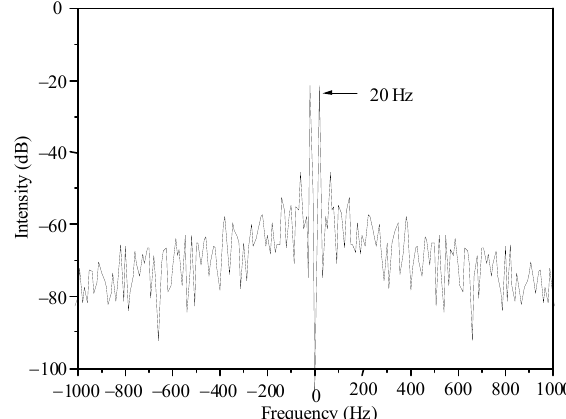
Fig. 2 Measured spectrum for a vibration at 20 H (the driving voltage of the vibrator is 0.8 V).